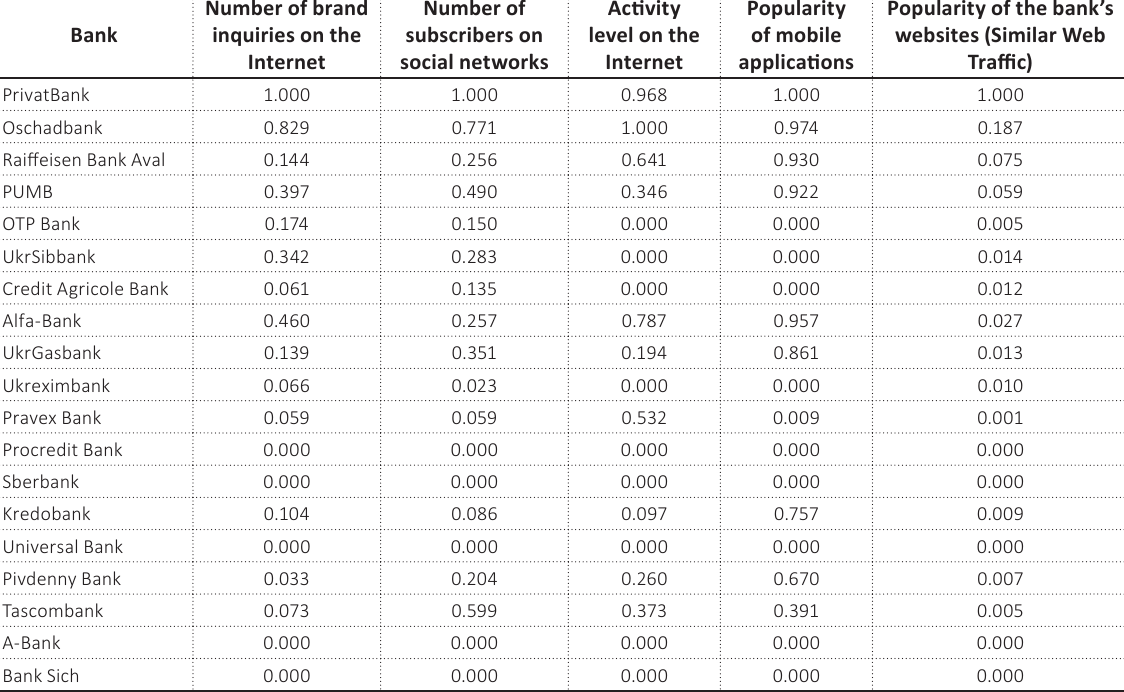
Table 2. Linear data transformation based on the digital transformation indicators designed to analyze the competitive capacity of Ukrainian